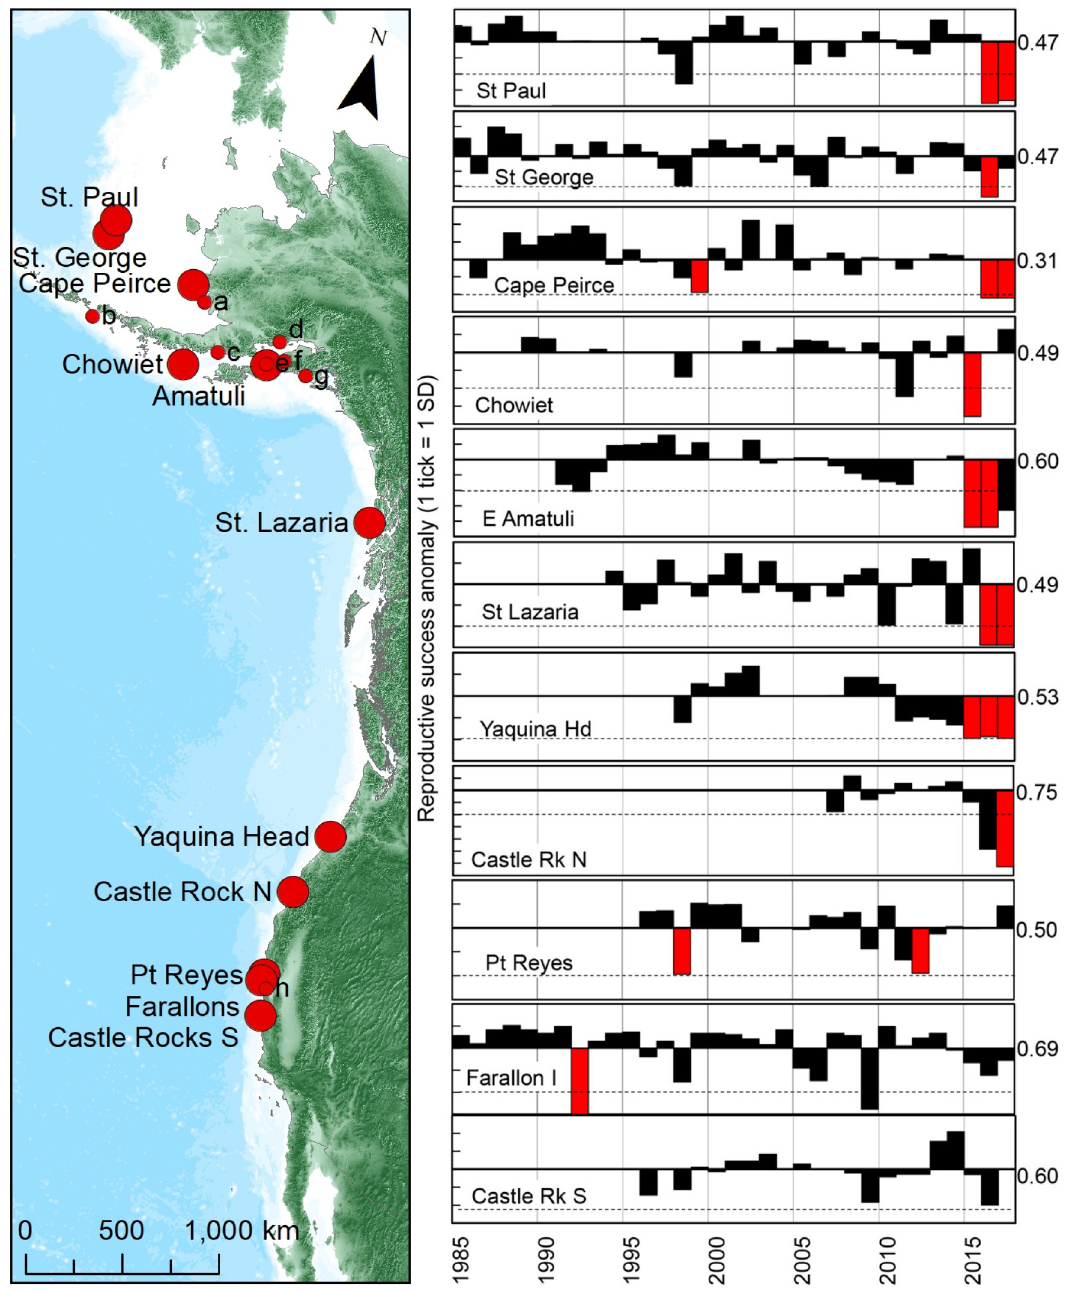
Fig 5. Annual standardized deviations in reproductive success of common murres (on right) at continuously monitored colonies (on left, large red circles) distributed over ~6000 km in the NE Pacific Ocean. Red bars (on right) indicate every known year of reproductive failure (i.e., success 0.0 to < 0.10 chicks/pair) from 1985 to 2014. Horizontal dashed lines indicate where reproductive success would fall two standard deviations below the long-term average (for pre-event average during 1996–2014, value at right of each plot). Smaller and/or irregularly monitored colonies (on left, small red circles) included (a) Round I., (b) Aiktak I., (c) Oil Creek, (d) Duck I., (e) Nord I., (f) Gull I., (g) Barwell Is., (h) Devil’s Slide